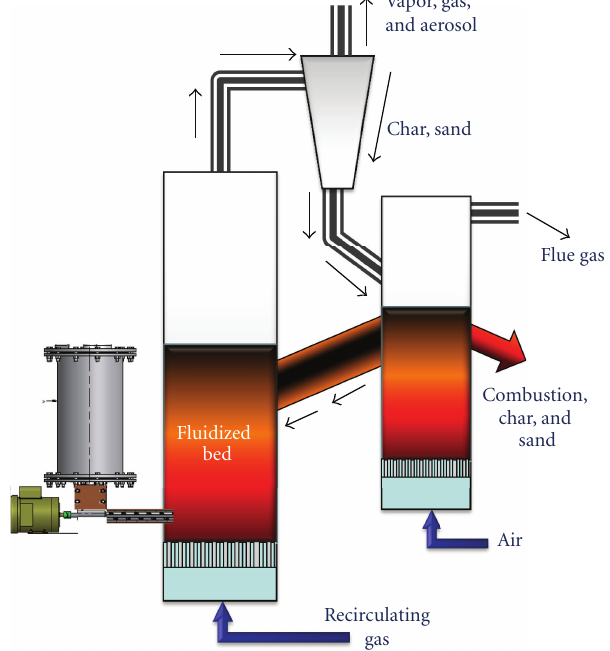
Figure 4: Schematic of recirculating fluidized bed pyrolyzer.